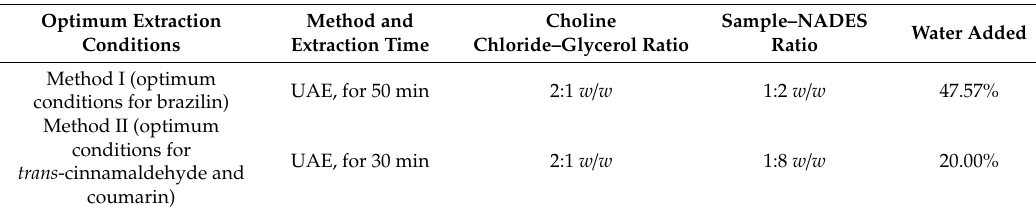
Table 3. NADES-based ultrasonic-assisted extraction (NADES-UAE) conditions for extraction of marker compounds from the sappan wood and cinnamon bark